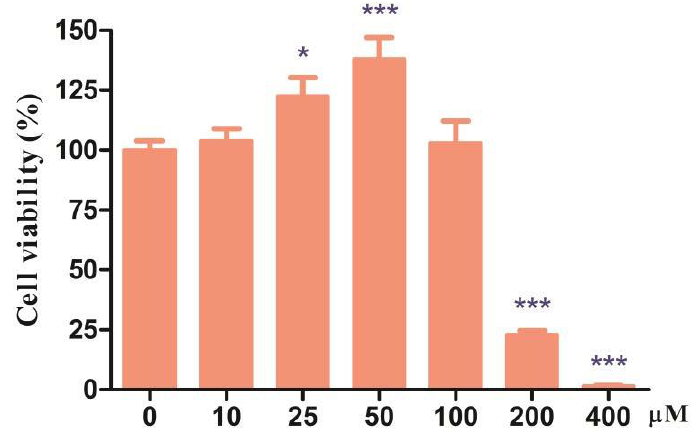
Figure 1. Effects of CDCA on the viability of IPEC-J2 cells ( n = 6). Cells were seeded at a density of 1.5 × 10 5 /well in 96-well plates. Values are presented as mean ± SEM and expressed as a percentage decrease or increase in cell viability. * p < 0.05, *** p < 0.001 compared with the CON group.